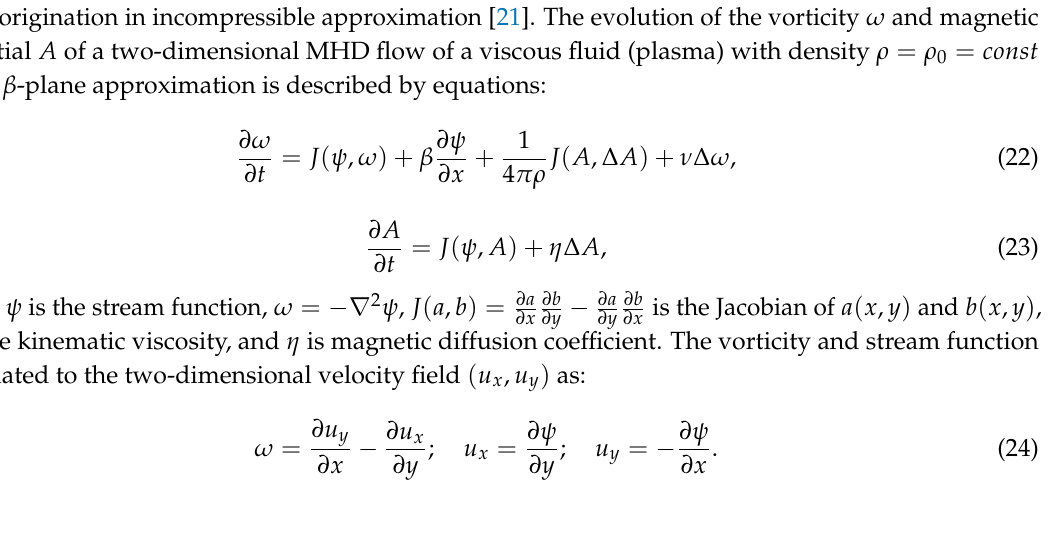
( k ) and curve 2 is a dispersion curve for magneto-Rossby 3 1 ( k − k ) + ω ( k ) . For waves ( b ) in horizontal magnetic field curve 3 is a MR 1 3 2 2 1 ( k ) and curve 4 is a dispersion curve for 3 2 ( k − k ) + ω ( k ) MR 2 3 2 2 2